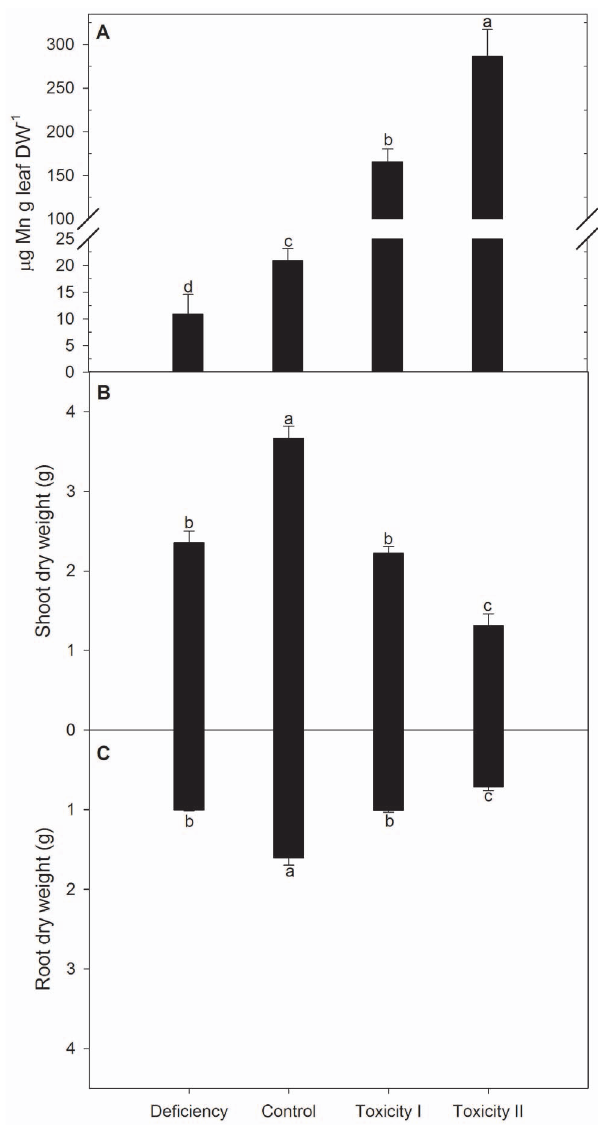
Fig. 4. The effects of insufficient, control or two increasing Mn toxicity levels on Mn accumulation in the youngest fully developed leaves (A), shoot dry weight (B) and root dry weight (C) of barley plants. Data are means ¡ SE ( n 5 3). Values with the same letter between treatments are not significantly different (P .